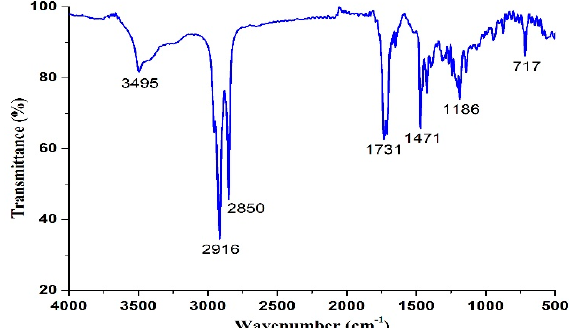
Figure 4. Fourier transform infrared (FTIR) spectrum of 1,3-LP.